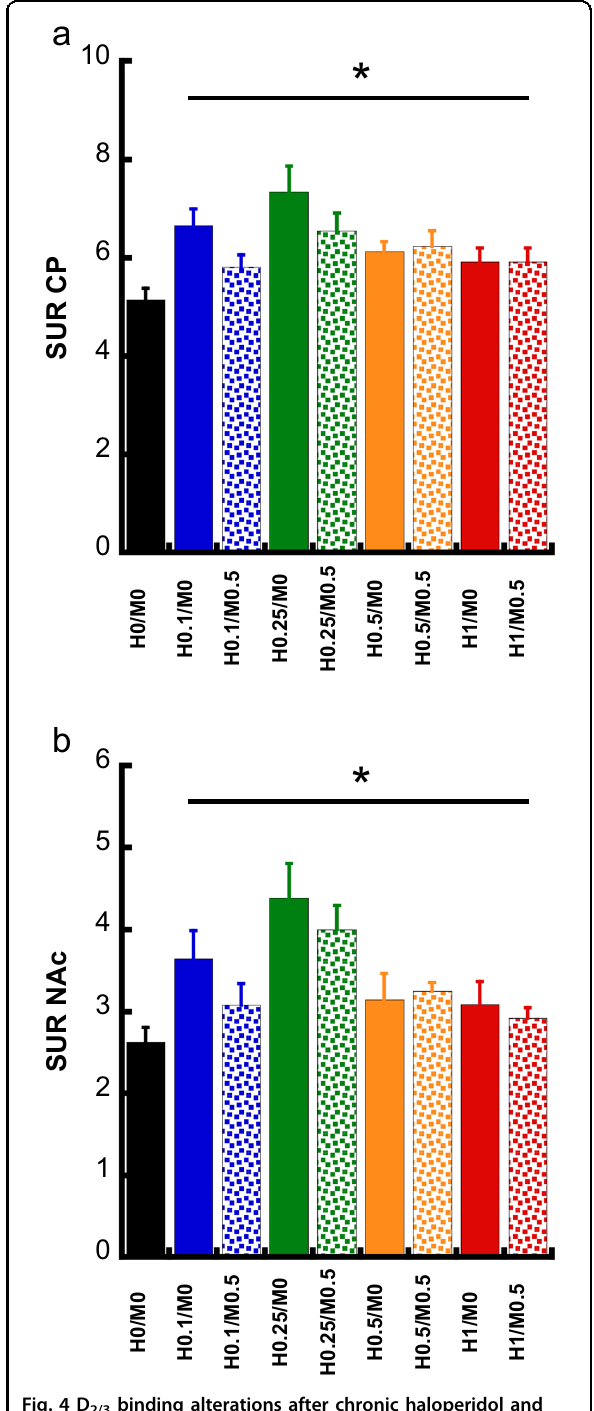
Fig. 4 D 2/3 binding alterations after chronic haloperidol and MDL-100,907 treatment. Receptor quanti fi cation was performed in the CP ( a ) and NAc ( b ) (mean± SD), one week after the end of the treatment period. *All groups present a signi fi cant increase compared to the controls